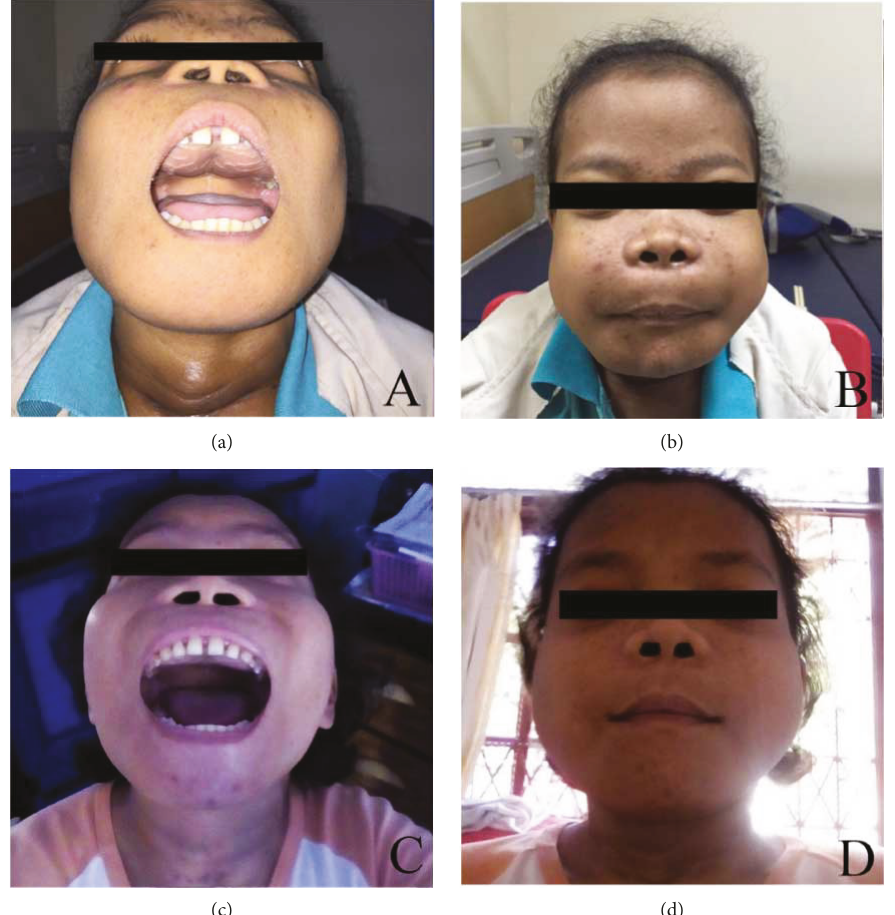
Figure 5: Case 2. (a) Hard palate mass. (b) Swelling in the bilateral maxilla and mandible. (c, d): Regressed mass after parathyroidectomy.